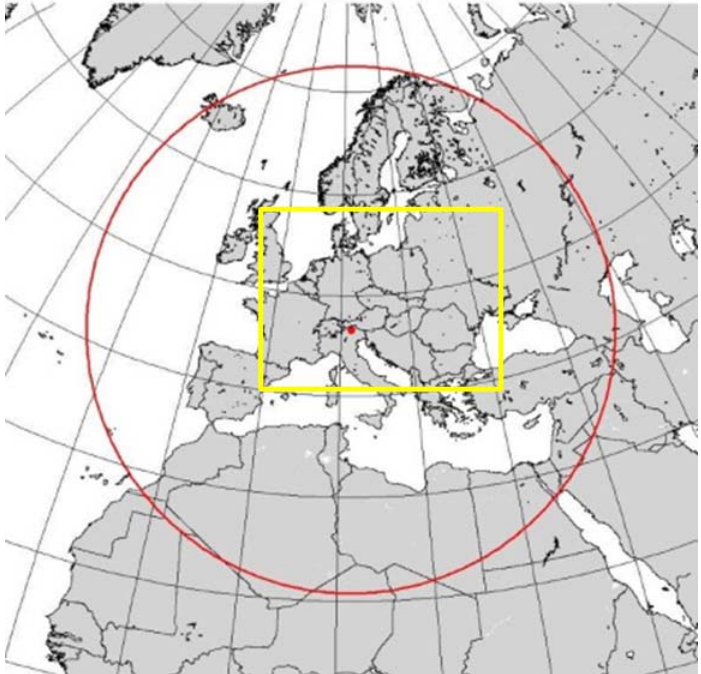
Figure 1. Area covered by the EURAC receiving station (red circle) and area covered by the snow product presented in this paper (yellow